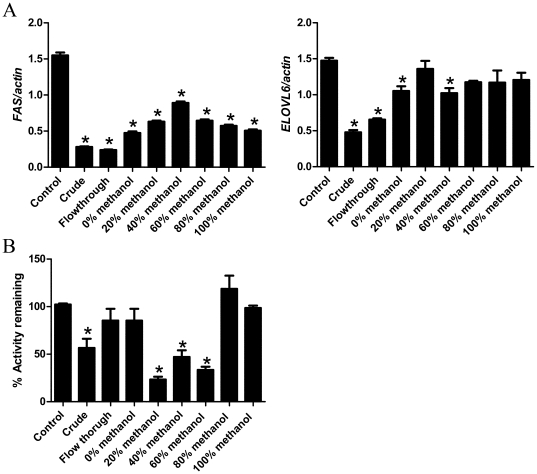
Effects of methanol fractions from WBM extract on FAS and ELOVL6 gene expressions and aromatase activity in HepG2 cells.Cells were incubated with each methanol fraction from WBM extract for 24 hours. (A) FAS and ELOVL6 gene expression was normalized with the β-actin housekeeping gene. (B) Microsome assays were performed to evaluate anti-aromatase effects of WBM using the substrate, [1-β-3H] androstenedione. Activity was calculated to measure supernatant containing [3H] H2O as reaction product, and then was counted in a Scintillation Counter. Aromatase inhibition activity was calculated as the percentage of remaining activity from the reaction without mushroom fractions. Analyses were carried out in triplicate and data were expressed as the mean ± SE. We analyzed the data for each treatment by ANOVA, followed by comparison of all treatment groups with the control group (Dunnett's test). Statistical significance was defined as P<0.05.